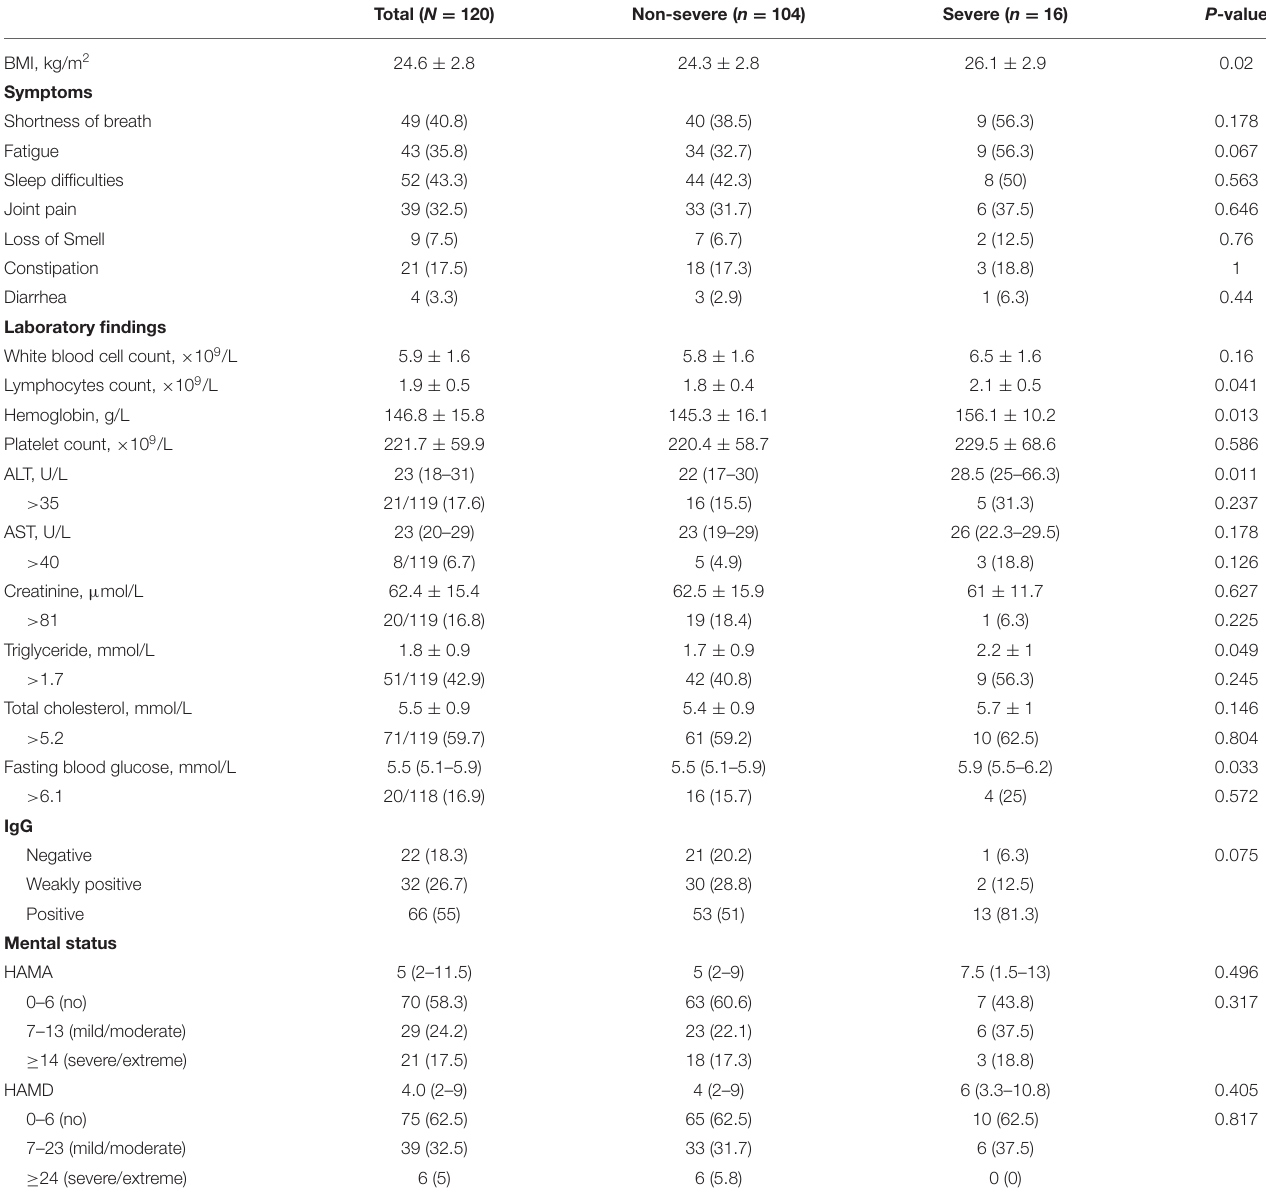
TABLE 2 | Symptoms, laboratory findings, and mental and cognitive status at the nearly 1-year